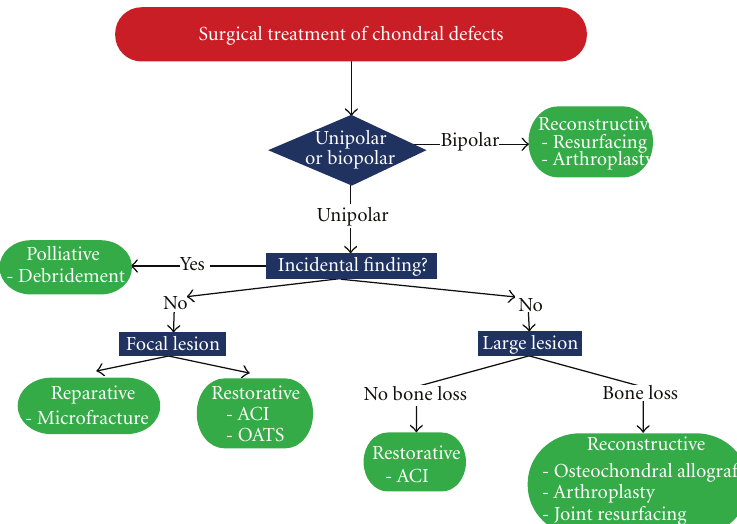
Figure 1: Approach to surgical decision making in patients with chondral defects of the glenohumeral joint. Adapted from